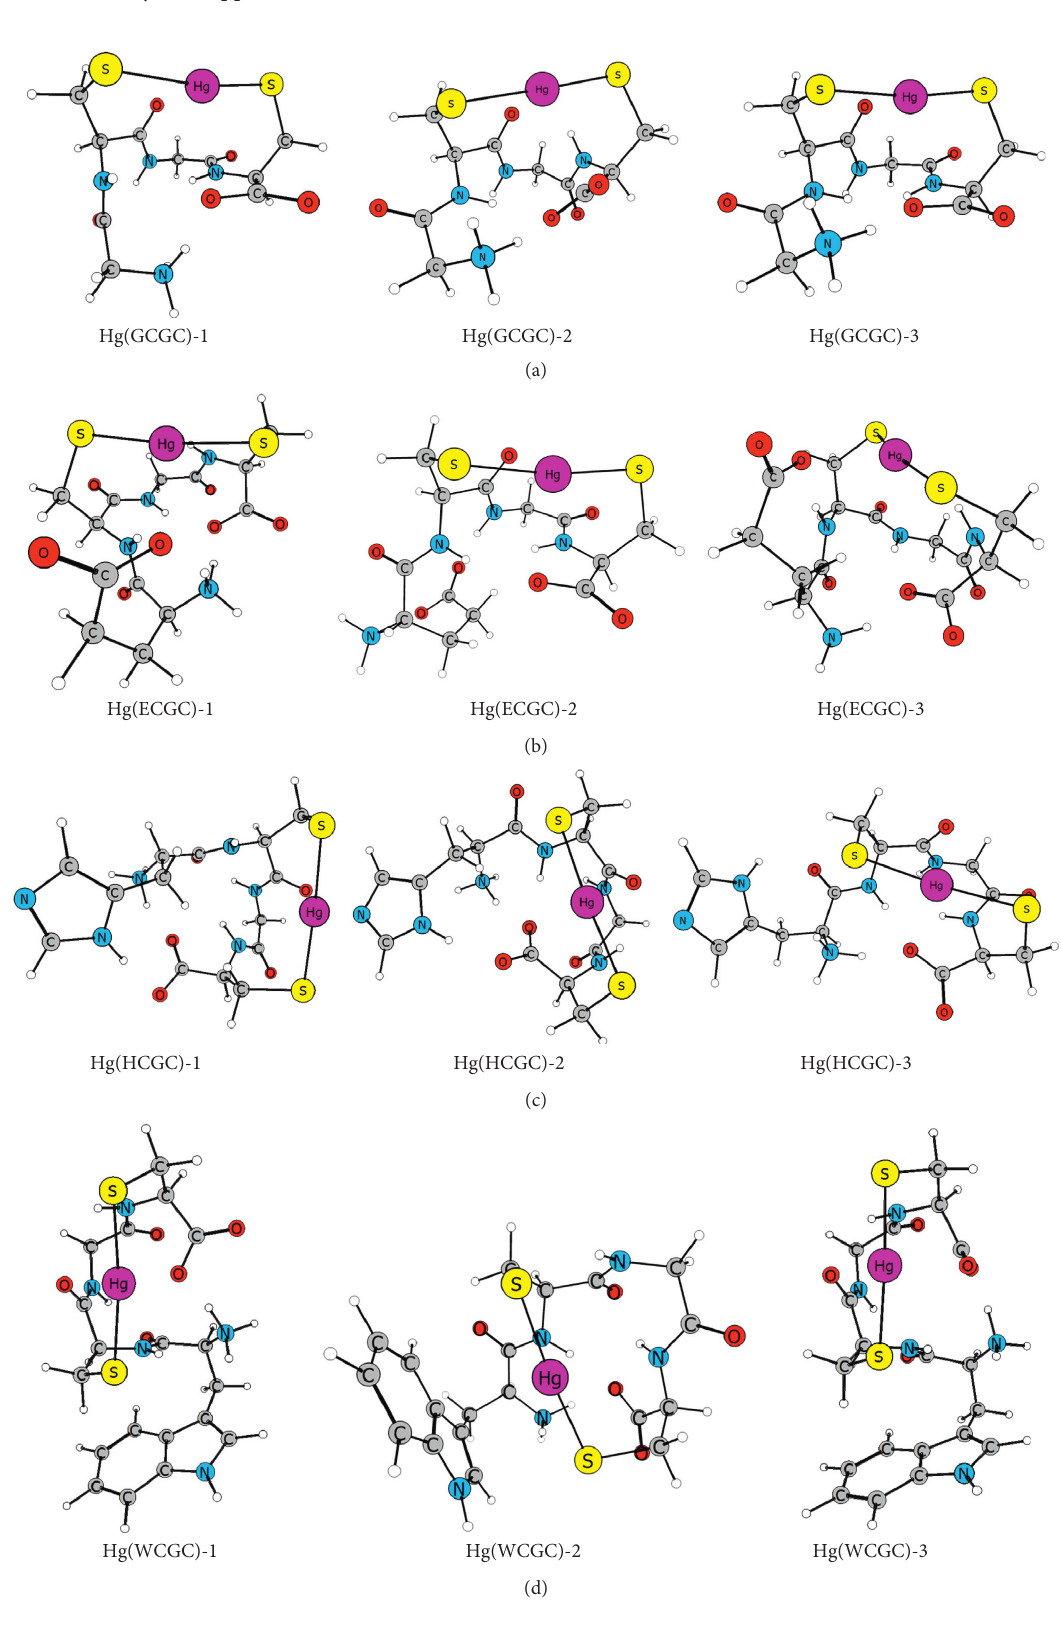
Figure 6: Three most stable Hg(XCGC) conformations ( G solution ) for each tetrapeptide where X is glycine (a), glutamate (b), histidine (c), and tryptophan (d). Complex with 1 designation is the most stable conformation in the